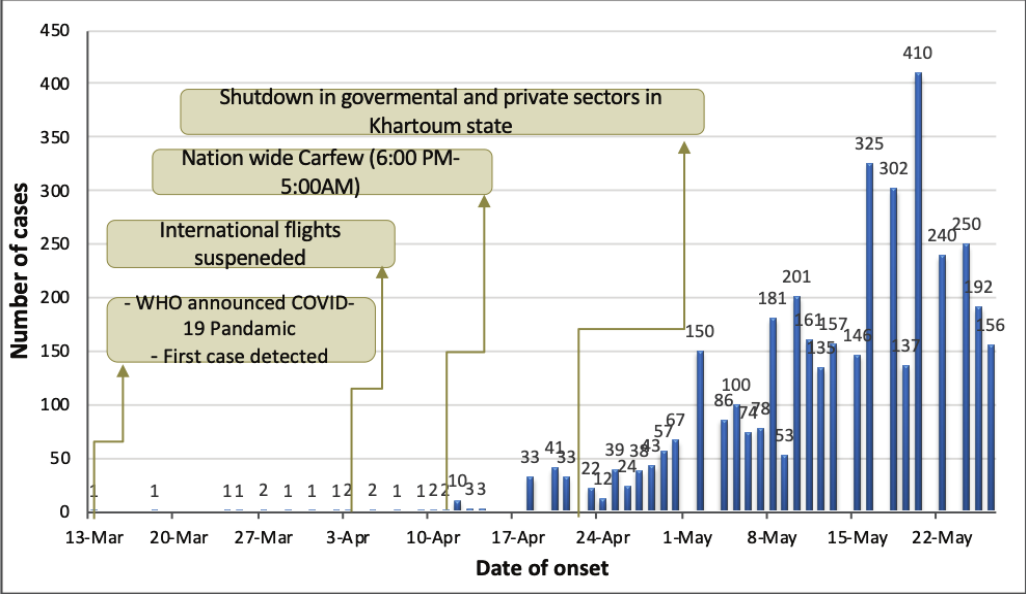
Figure 2: Confirmed number of COVID-19 cases in Sudan as of May 14, 2020 and mitigation measures. Source: Federal Ministry of Health – Sudan (http://www.fmoh.gov.sd)